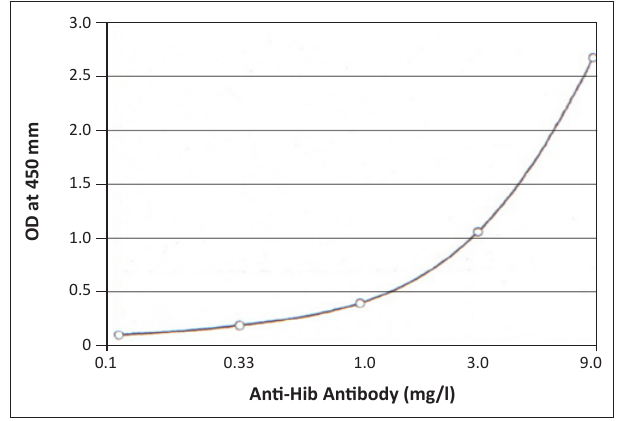
FIGURE 1: VaccZyme™ Anti-Hib Enzyme-linked immunosorbent assays calibration curve as provided on the quality control sheet. 9